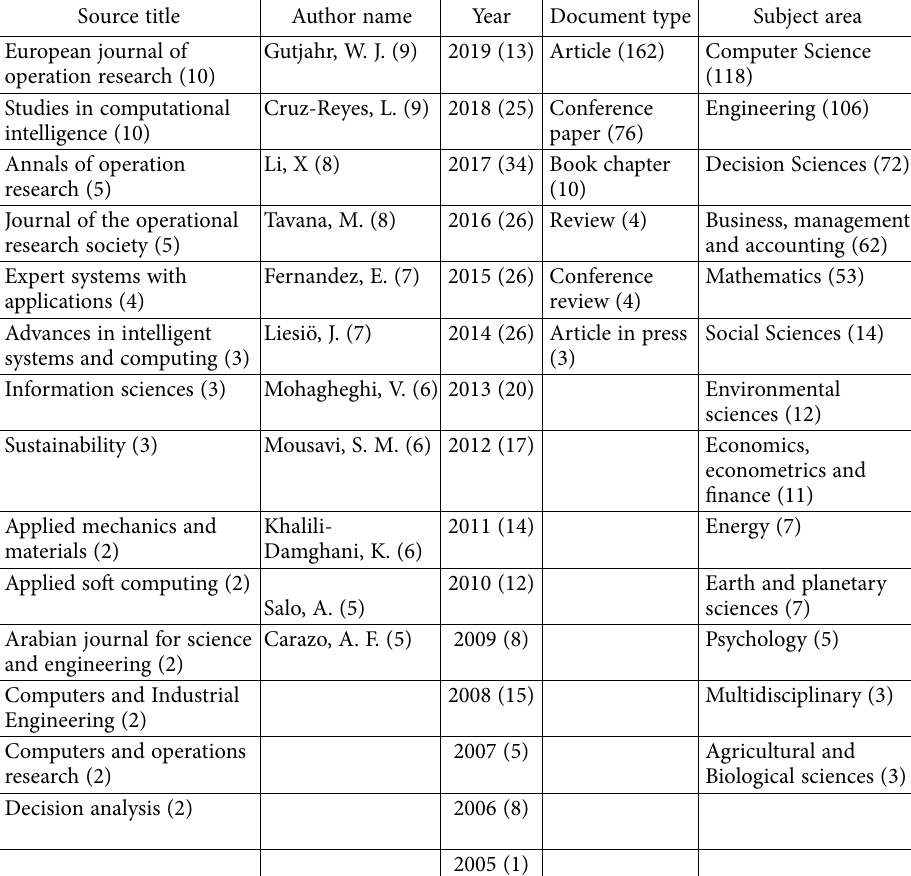
2. Trend of PPS studies between 1996 to Table 1. A statistical report from SCOPUS to PPS